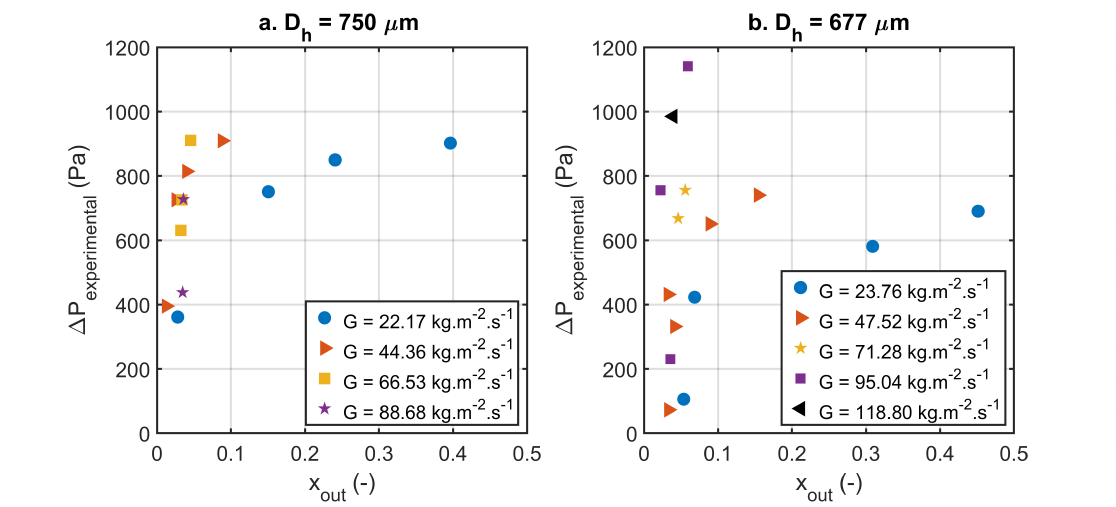
Figure 11. pressure drop vs. vapor. ( a ) channel cross Section 1.50 mm ˆ 0.5 mm. ( b ) channel cross Section 1.050 mm ˆ 0.5